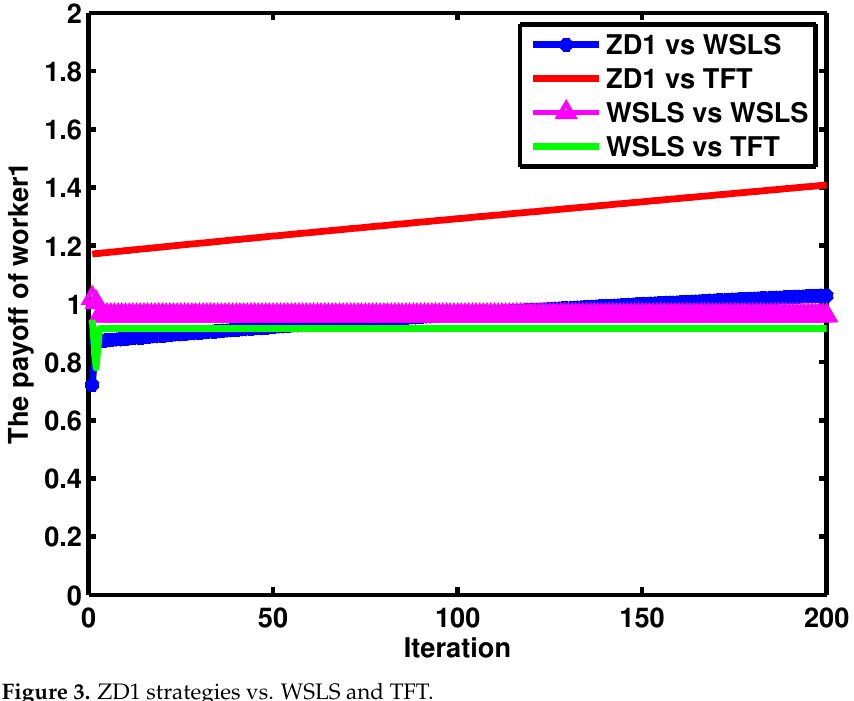
Figure 3. ZD1 strategies vs. WSLS and TFT.